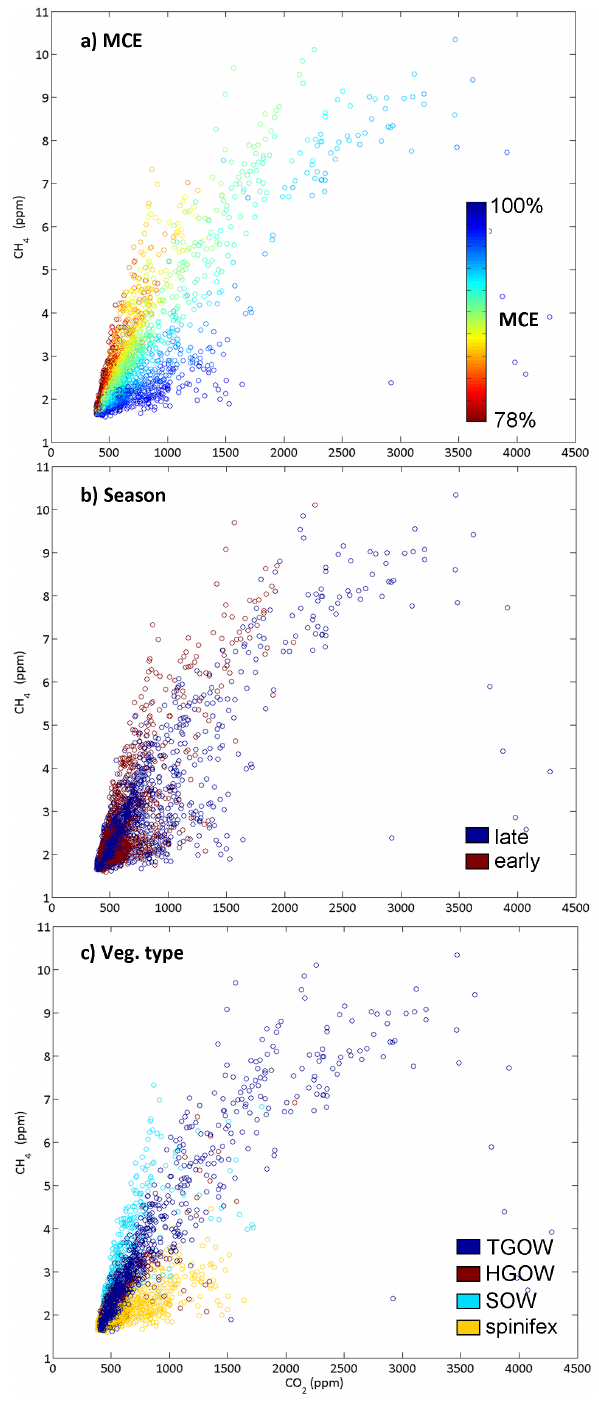
Figure 11. Scatter plots of the measured mole fractions of CO 2 and CH 4 , including all measurements made during the two Arnhem Land campaigns in 2009. All three plots show the same data, but are colour-coded differently using (a) MCE; (b) season of measure- ment; and (c) vegetation class.